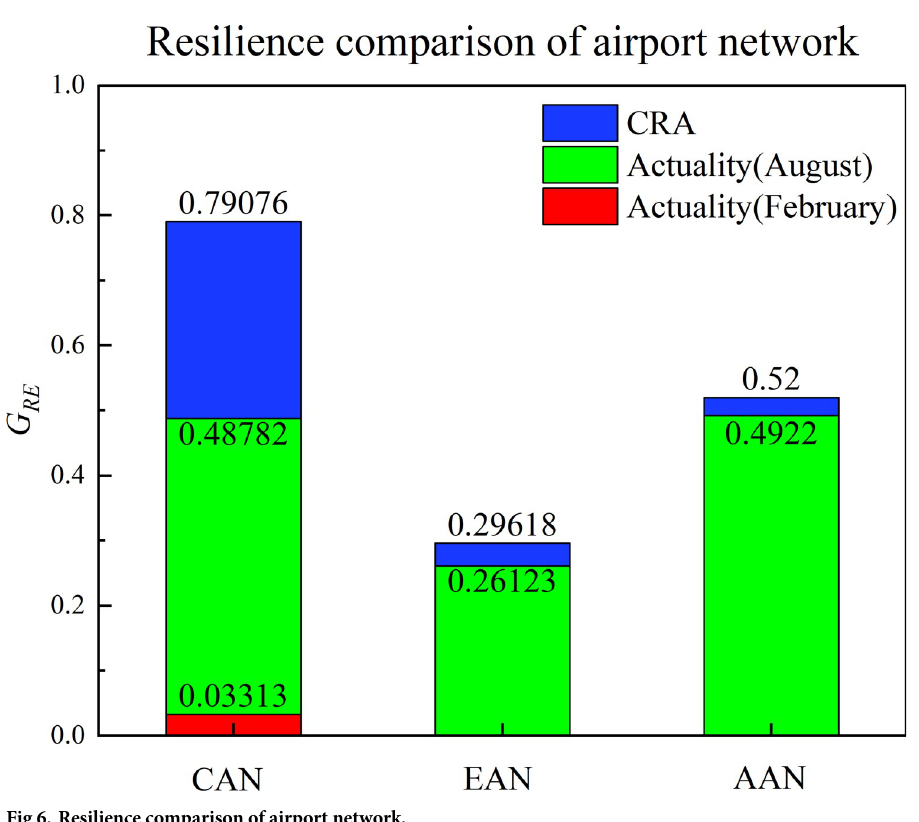
Fig 6. Resilience comparison of airport